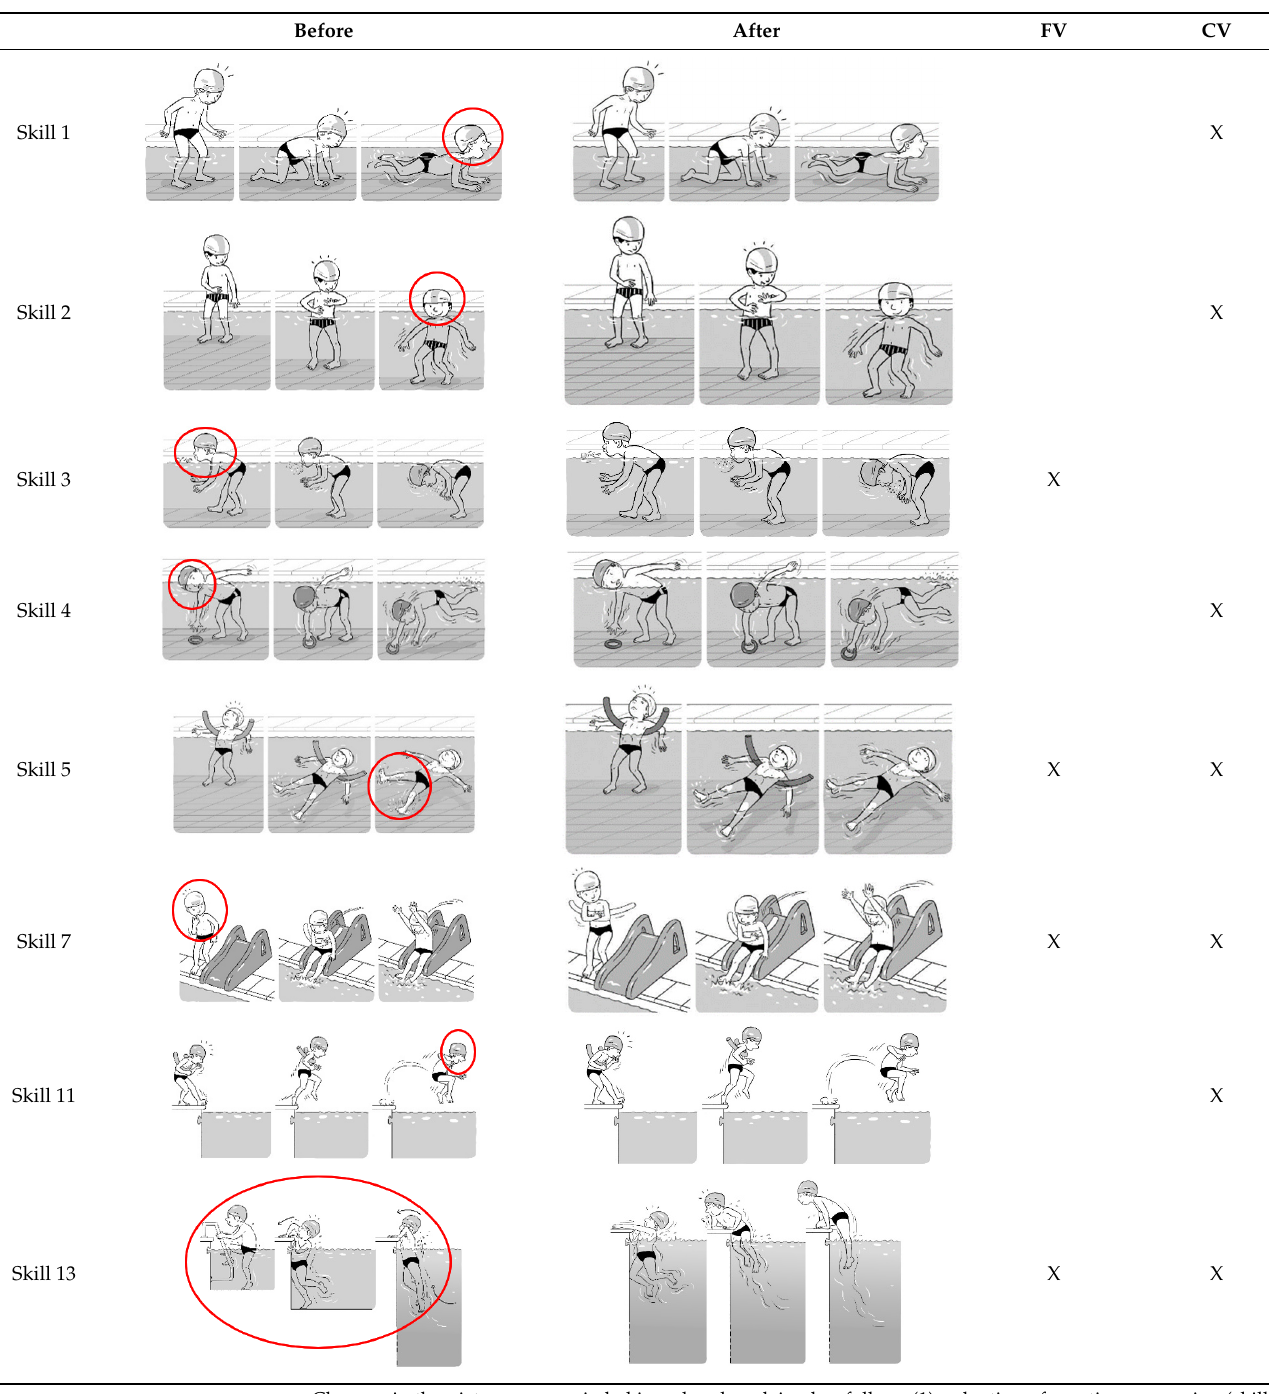
Table A2. Graphical changes by the Face Validity (FV) and Content Validity